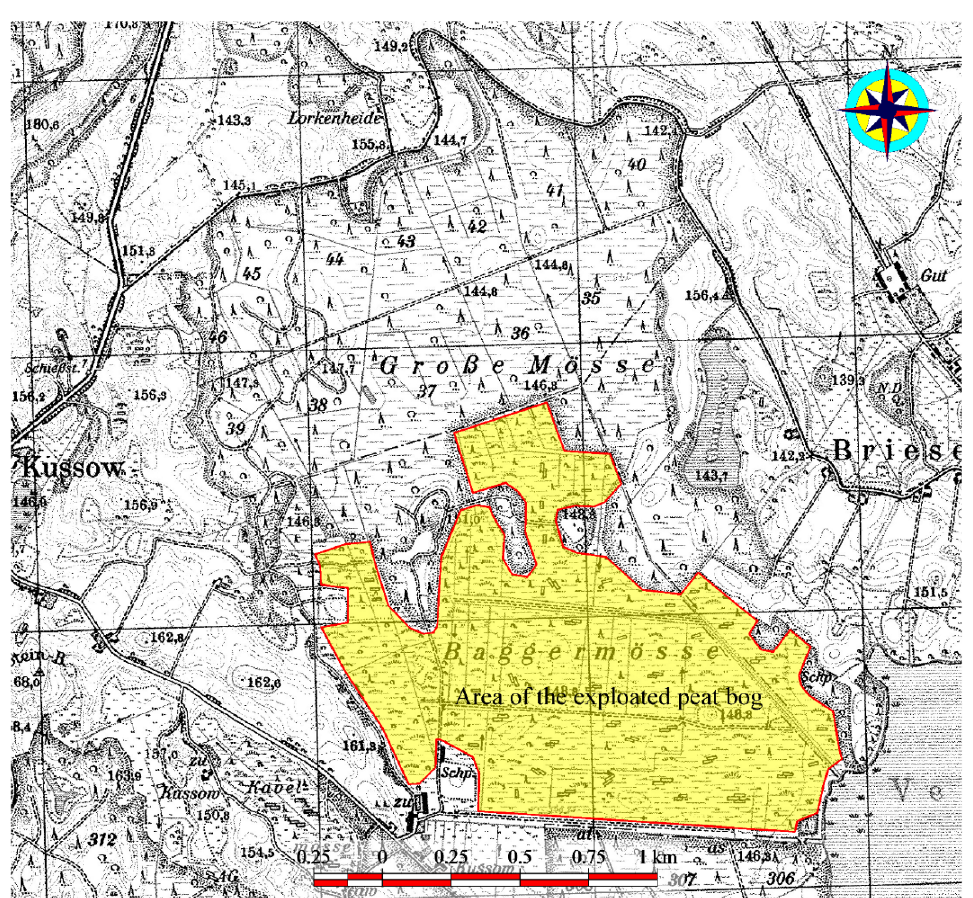
Figure 2. Topographic map of the bog Bagno Kusowo and its vicinity in 1939, with marked areas of peat extraction (according to [25]). peat extraction (according to